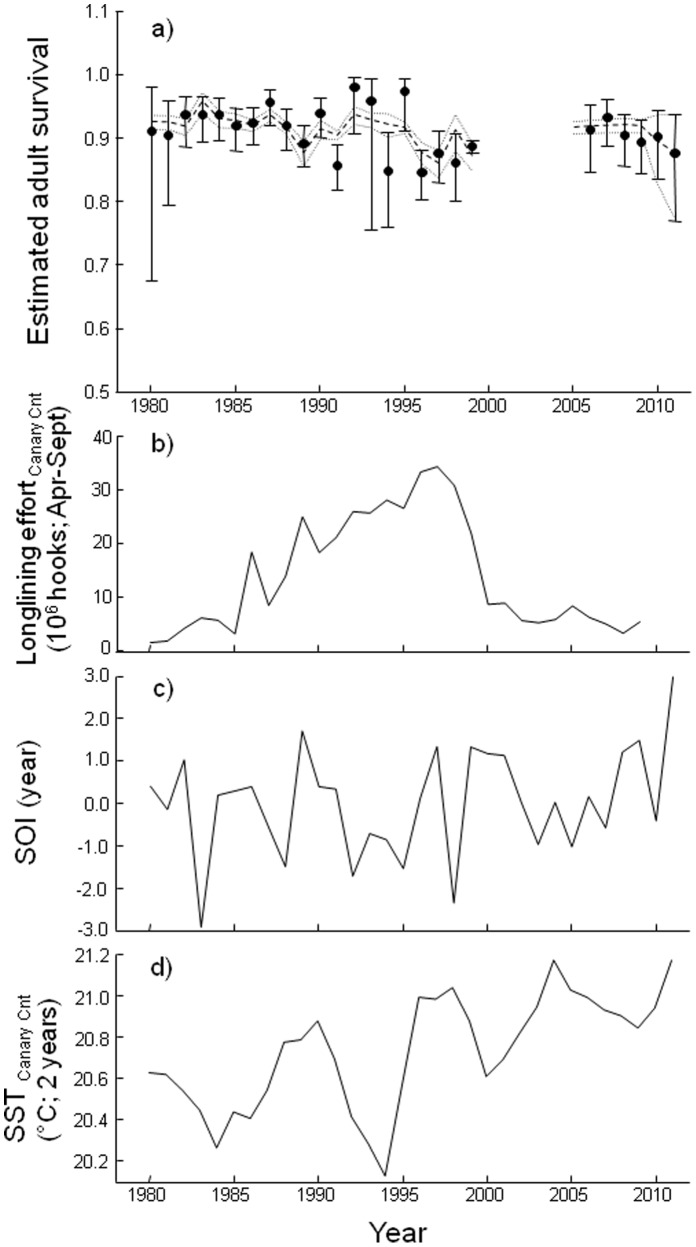
Annual variation of adult survival probabilities and the selected covariates for the period 1980–2011.Variation in survival rates of adults (a) and the selected covariates: (b) longlining effort in the Canary Current during the breeding, (c) annual SOI and (d) SST in the Canary Current (2 years averaged) are shown separately. Survival estimates come from the time-dependent model (Φt pm+t; in black dots and CI in solid bars) and from the selected model with the covariates (ΦLLccbr+SOIyr+SSTcc2yr pm+t; in dense dashed line and CI in light dashed lines).